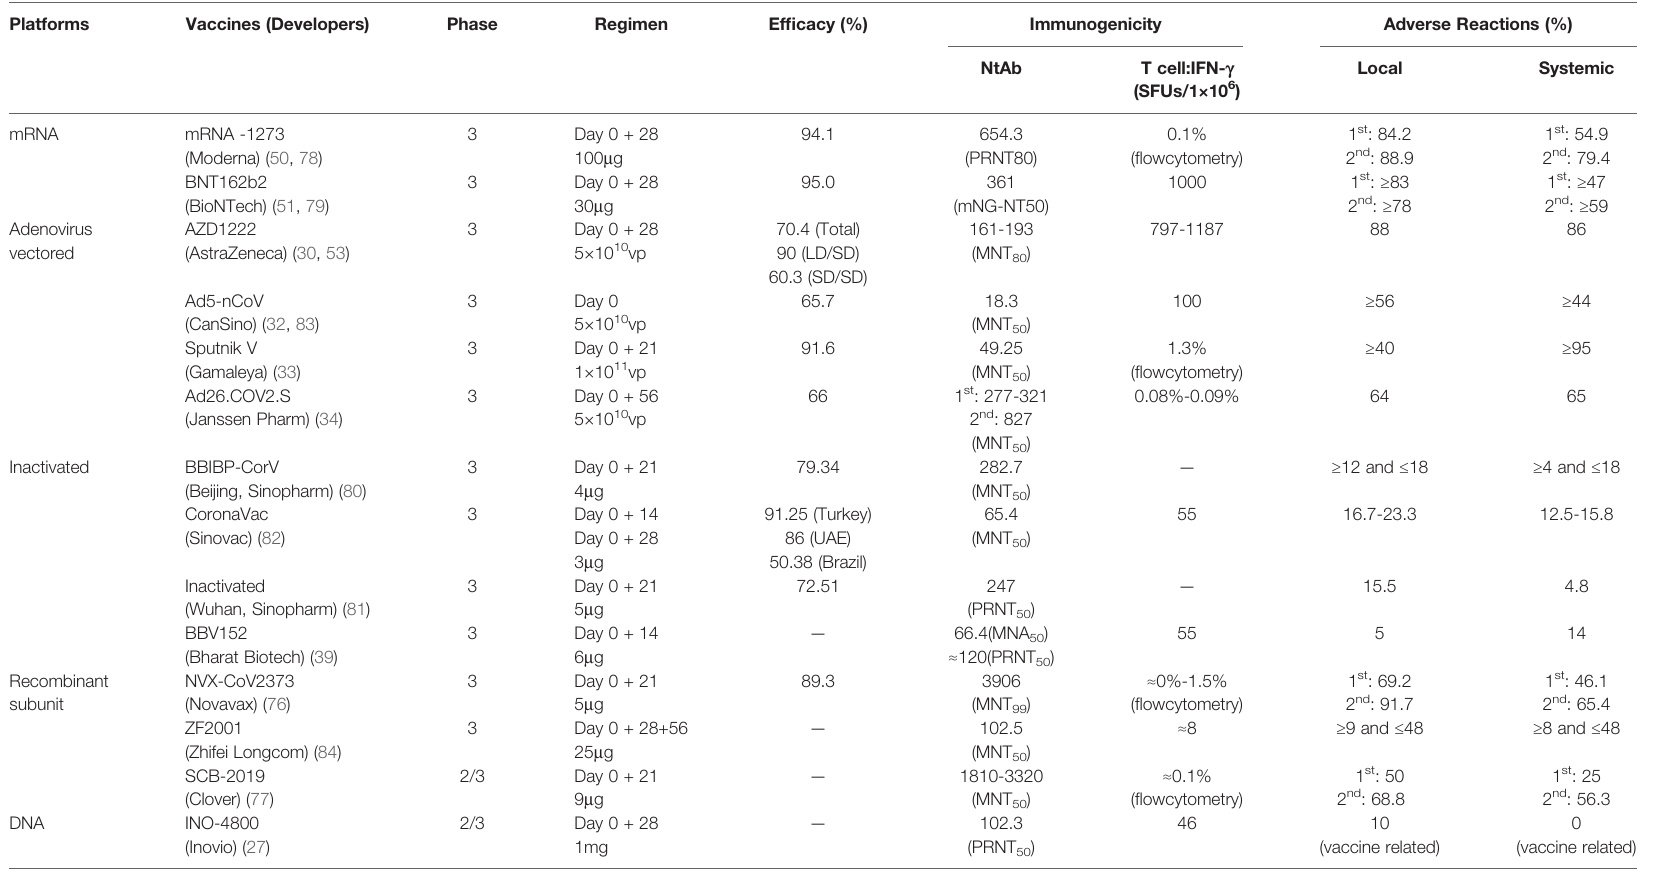
1. NtAb, Neutralizing Antibody; SFUs, Spot Forming Units; MNT, Micro-neutralization Test; PRNT, Plaque Reduction Neutralization Test. 2. All data were collected from the current released reports for each vaccine. The measurement methods and detection virus strains are different for each vaccine candidate, and the results are incomparable. The table is for reference